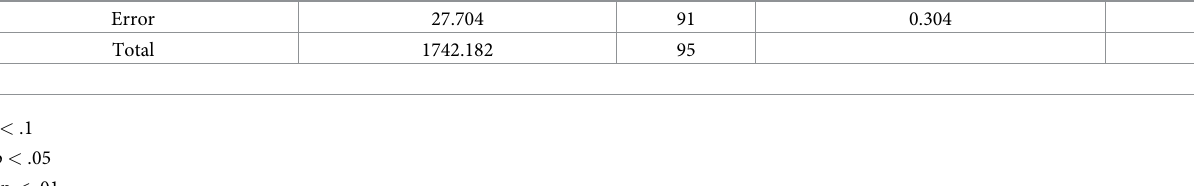
The path coefficient represented the strength and direction of a pair of constructs, and the hypothesis test verified their causal effects. The path coefficients and R 2 values revealed the degree of fit between the structural model and the actual data. The results for the relationships between the research framework and all the constructs are displayed in Fig 5. The R 2 value was 0.326; therefore, 32.6% of the total variance in LS was explained by this model. The analysis of the PLS-SEM revealed the following relationships among the constructs: CL ( β = 0.503, p < 0.05) and PA ( β = 0.221, p < 0.05) positively affected LS, whereas CL × PA ( β = − 0.186, p < 0.05) negatively affected LS. The results of the PLS-SEM analysis indicated that all pro- posed research hypotheses were supported. The results are summarized in Table 3.